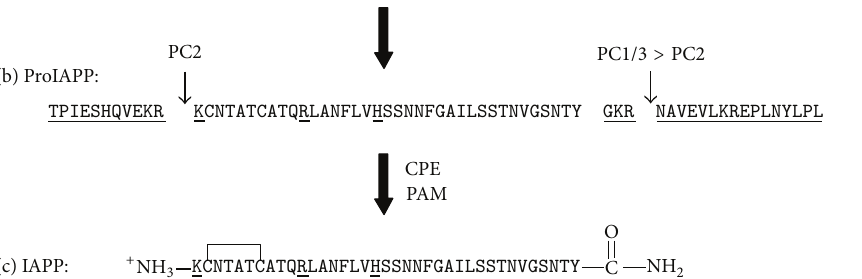
Figure 2: Processing of human PreProIAPP to produce mature IAPP. (a) The primary sequence of the 89-residue human PreProIAPP. The 22-residue signal sequence is shown in italics; the N- and C-terminal proIAPP flanking regions are underlined. (b) Primary sequence of the 67-residue proform of human IAPP. Pro-hIAPP is cleaved by the prohormone convertases PC(1/3) and PC2 at two conserved dibasic sites, indicated by arrows. The amidated C-terminus is produced after further processing by CPE/PAM. (c) The sequence of the mature 37-residue human IAPP. The biologically active peptide has an amidated C-terminus and a disulfide bridge between Cys-2 and